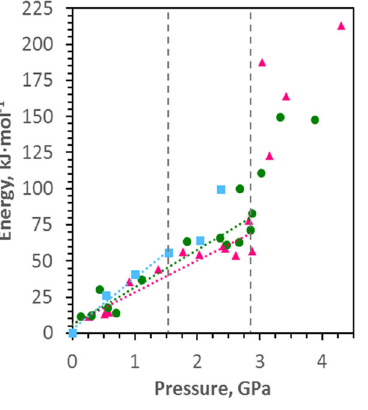
Fig.6|EnergychangesfortheM(OAr) 4 complexesasafunctionofpressurefor M=Th (pink triangles), U (green circles) and Np (blue squares). Linear regres- sion analysis of values up to ca. 2.8GPa for Th and U, and ca. 1.5GPa for Np: R 2 =0.90, 0.88, and 0.98 for Th, U, and Np, respectively. The linear regression analysis extends in each case from ambient conditions up to the phase transition pressure (2.8GPa for Th/U and 1.5GPa for Np, indicated on the plot with vertical dashed lines.